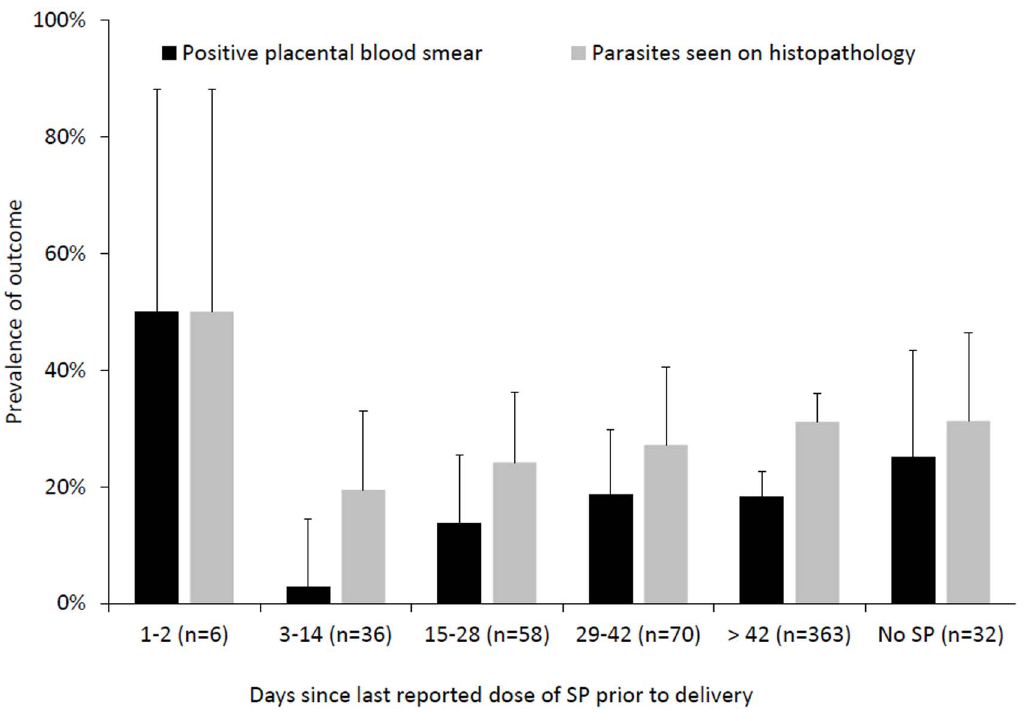
Figure 2. Risk of a positive placental blood smear and active malaria defined as the presence of parasites using histopathology stratified by number of days since last reported dose of SP taken.